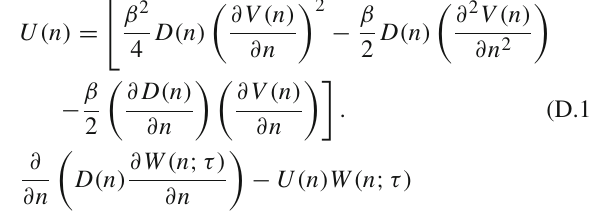
D Generalized solution of Fokker–Planck equation